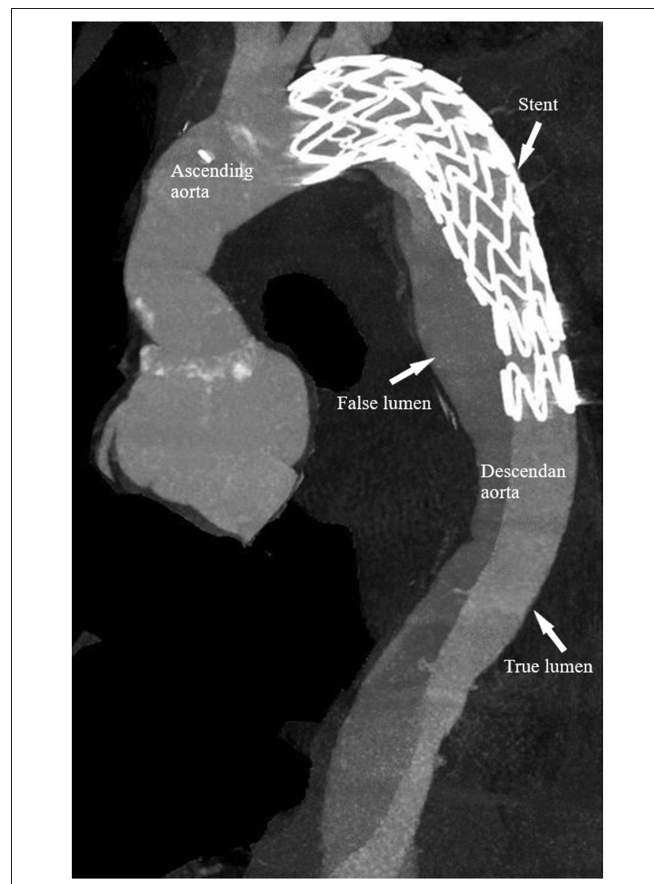
Figure 1. Computerized tomographic angiography; stent (extending from ascending aorta to descending aorta), intimal dissection extending to the abdominal aorta and true/false